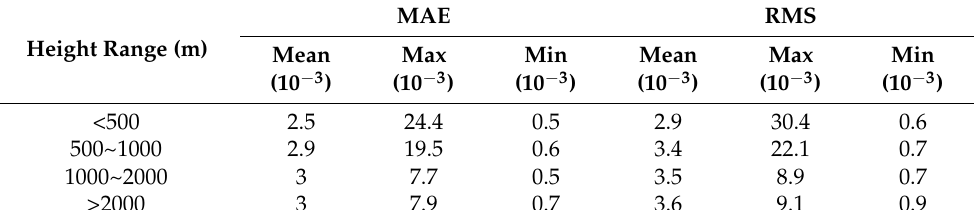
Table 3. Statistical results: MAE and RMS for the G Π model across different height ranges in 2014.